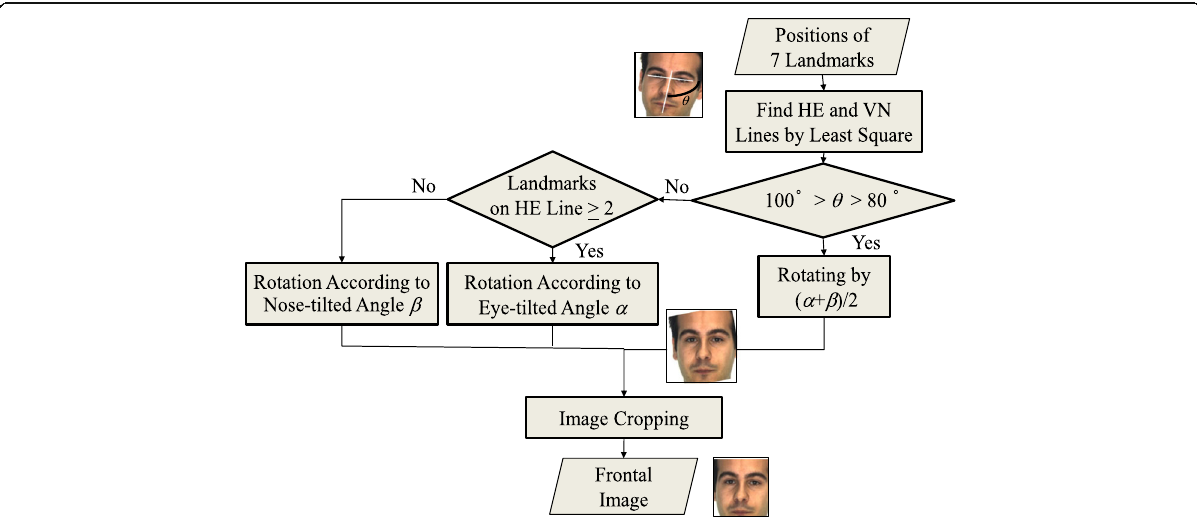
Fig. 9 Flow diagram of conditional cross warping for tilted